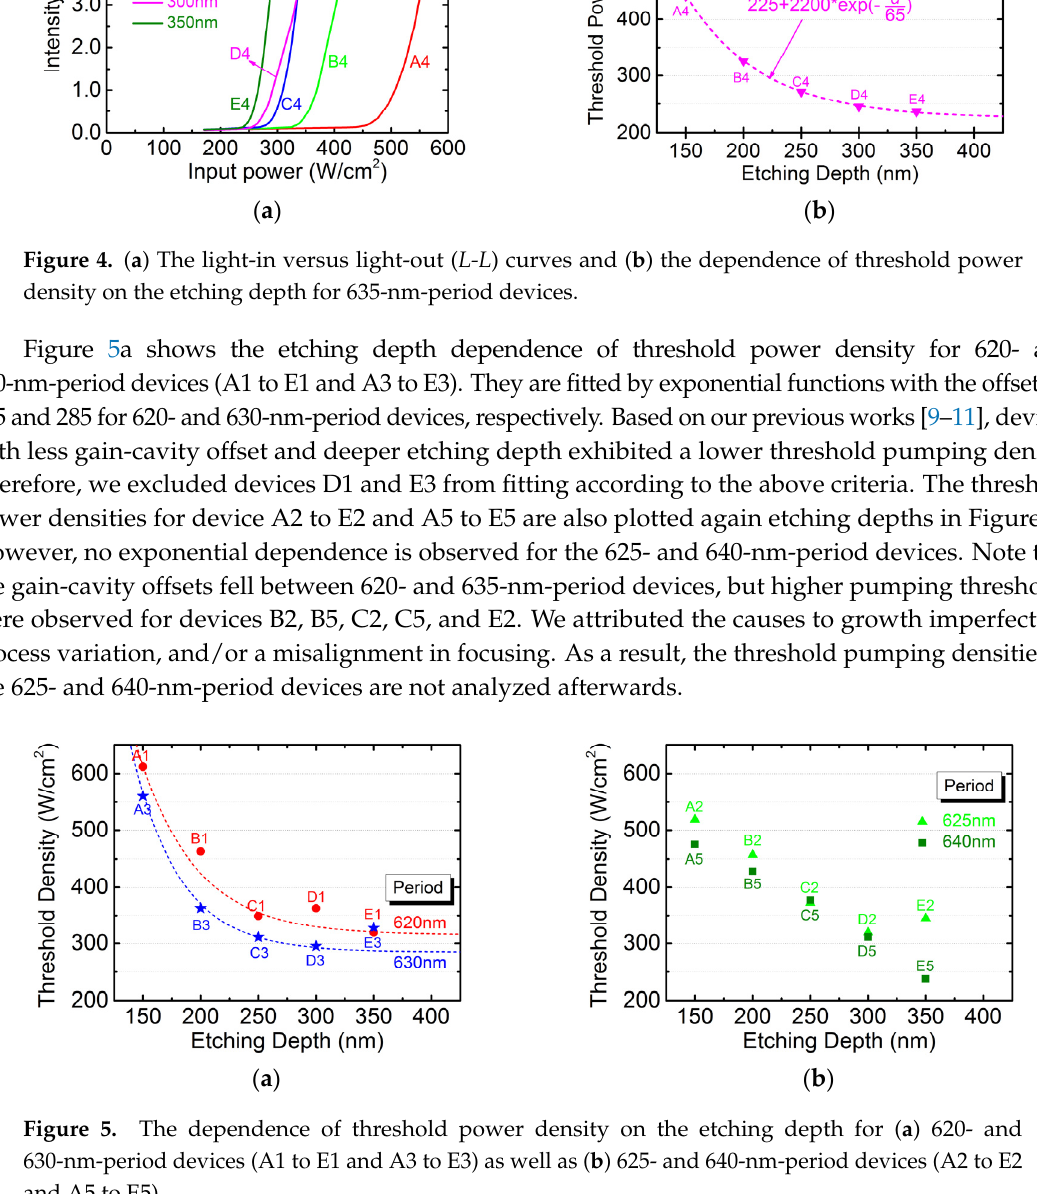
Figure 3. ( a ) The normalized lasing spectrum for devices with fixed lattice period of 635 nm. ( b ) The peak lasing wavelength versus etching depth for 25 devices.